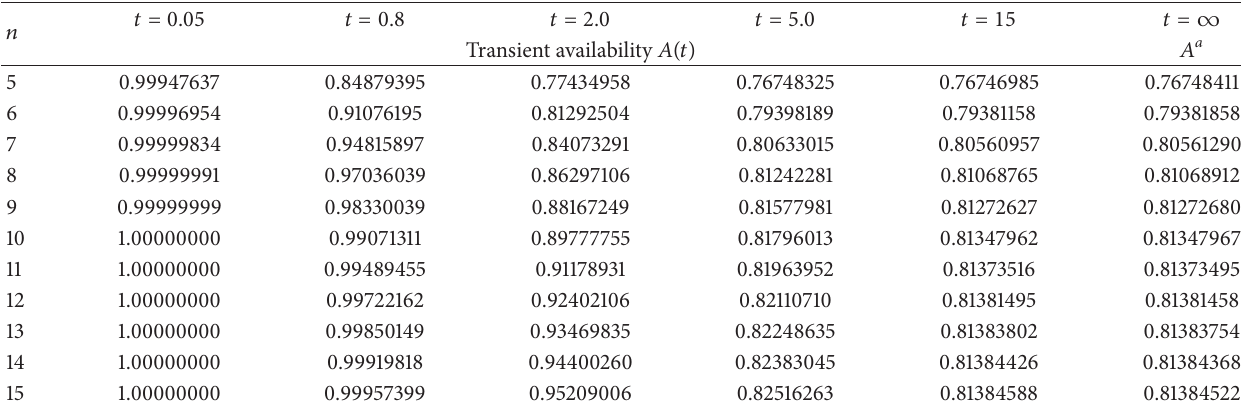
Table 5: Transient availability for different values of 𝑛 .